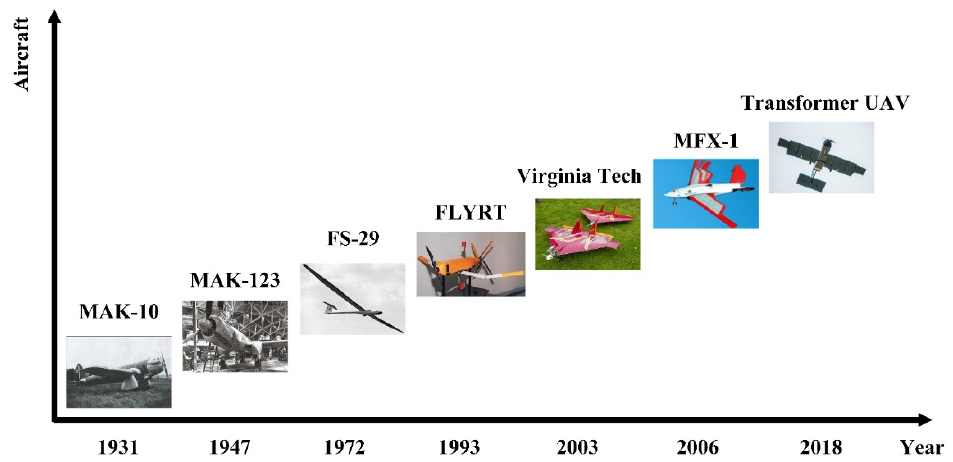
Figure 1. Aircraft that flew with span morphing wings. Reprinted/adapted with permission from Ref. [5]. 2020, Elsevier Ltd. Ref. [5]. 2020, Elsevier